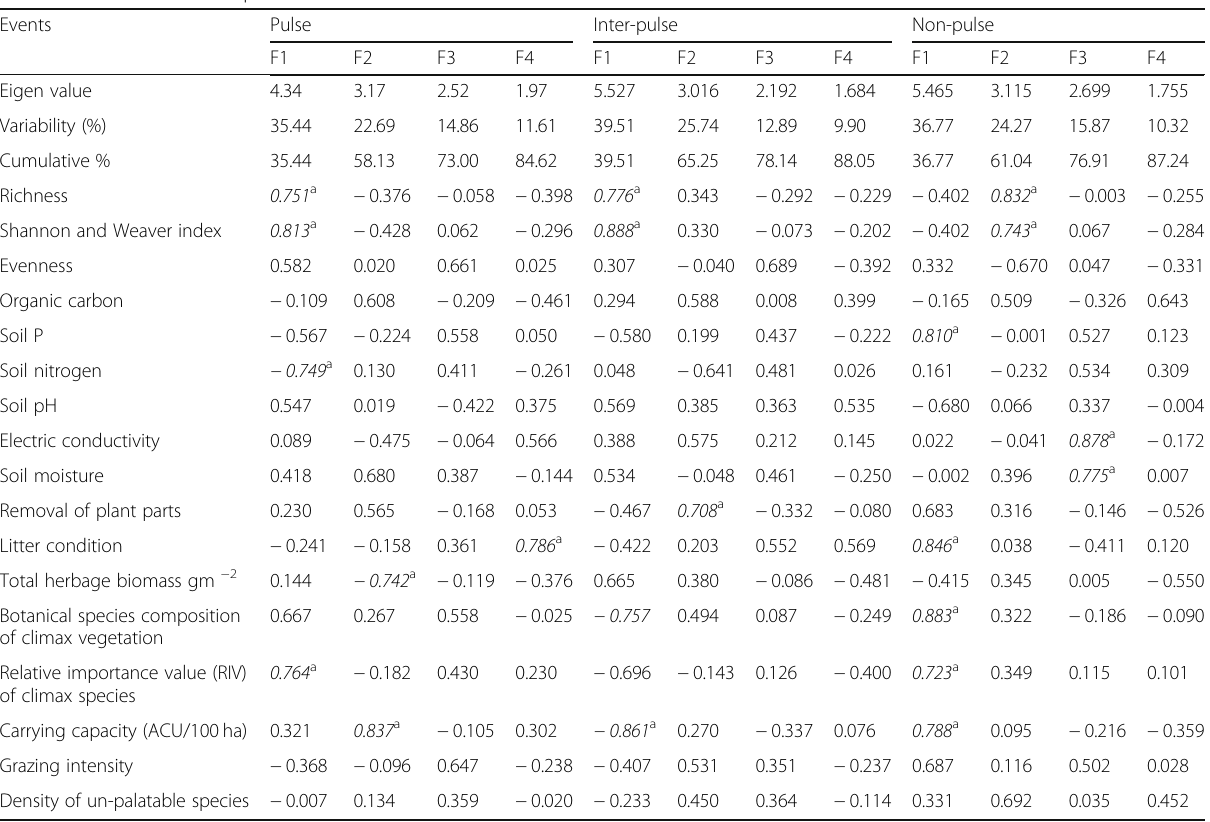
Table 5 Attributes of PCA pertains to various variables